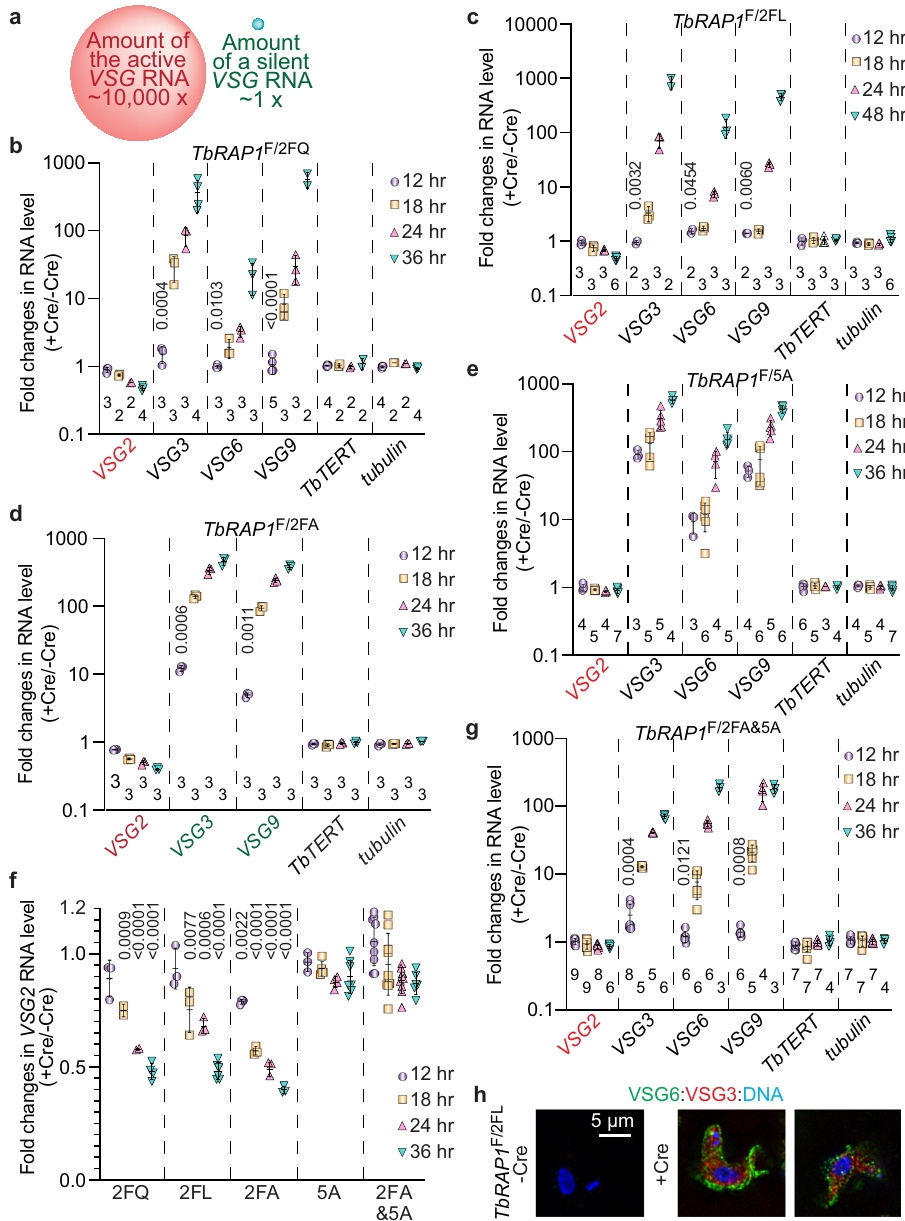
Fig. 5 | Tb RAP1 RRM is essential for full-level expression of the active VSG . a A diagram illustrating the ~10,000-fold difference between the active VSG RNA amount and any silent VSG RNA amount. Spheres are not drawn to scale. b – e , g qRT-PCRofRNAlevelsoftheactive VSG2 (indicatedinred),severalsilentES-linked VSGs , and chromosome internal TbTERT and tubulin in TbRAP1 F/2FQ ( b ), TbRAP1 F/2FL ( c ), TbRAP1 F/2FA ( d ), TbRAP1 F/5A ( e ), and TbRAP1 F/2FA&5A ( g ) cells. The fold changes in RNA level are shown in the log scale. Average and standard deviation were calcu- lated from two to nine independent experiments (exact number of samples are indicatedbeneath each column).The changein VSG2 RNAlevelin these mutants is plottedagaininthelinearscalein( f ).Atthe12hpoint,derepressionof VSG3 , 6 ,and